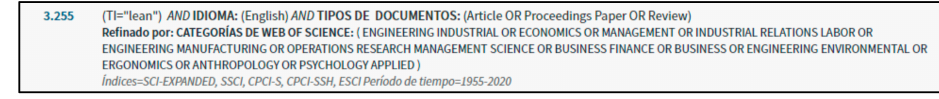
Figure 1. Web of Science search